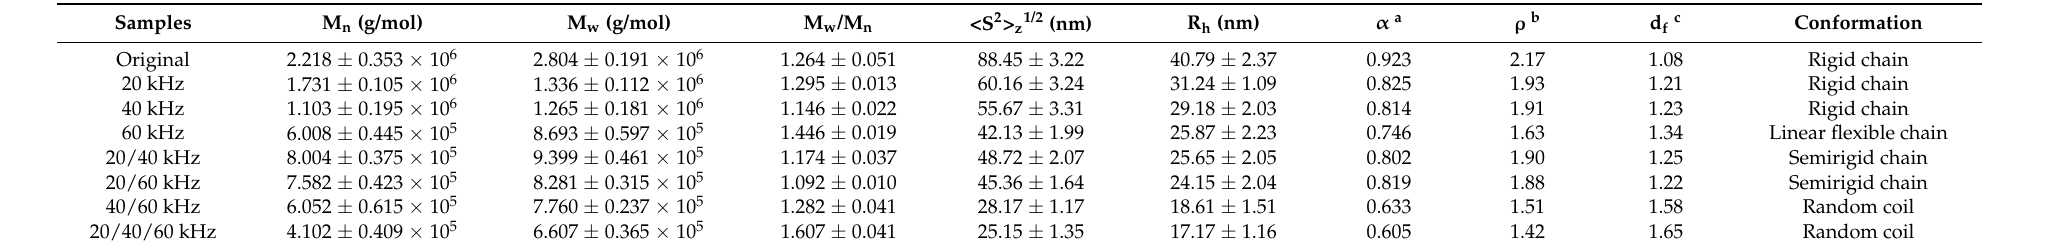
Table 2. Physicochemical properties and molecular parameters of lentinan at different ultrasonic frequency modes before and after ultrasonic treatment.